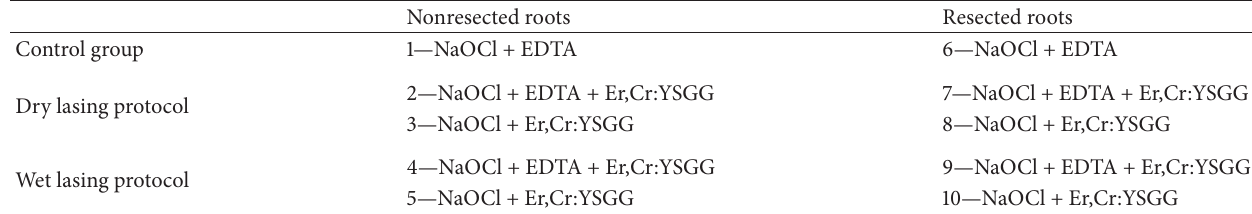
Table 1: Distribution of the teeth among the experimental subgroups